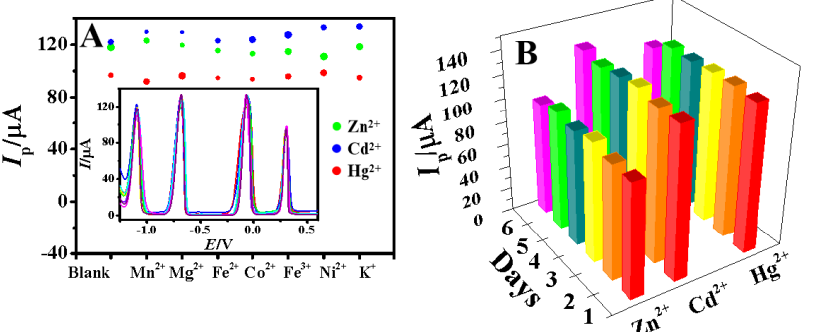
Figure 8. ( A ) The stripping peak currents of 100.0 µ M Zn 2+ , Cd 2+ , Hg 2+ on Bi–GDY/GCE with 10 − fold interfering ions (n = 3), the size of dots represents the peak current deviations (inset the overlay of corresponding DPASV curves), ( B ) Histogram of the peak currents of 100.0 µ M Zn 2+ , Cd 2+ , Hg 2+ and 0.1 mM Bi 3+ for six consecutive days.